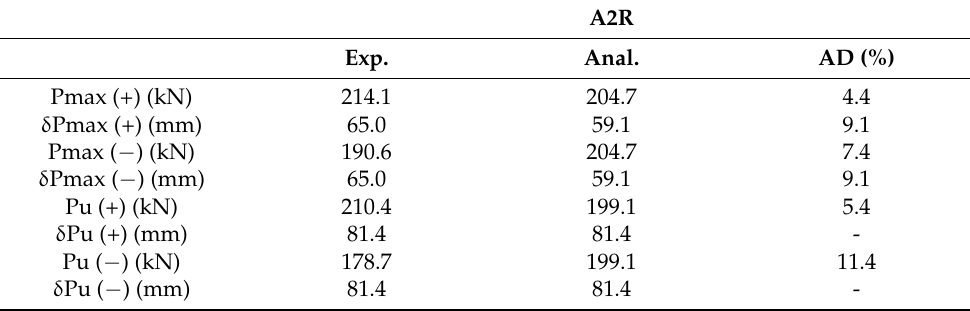
Table 6. Comparative results for A2R